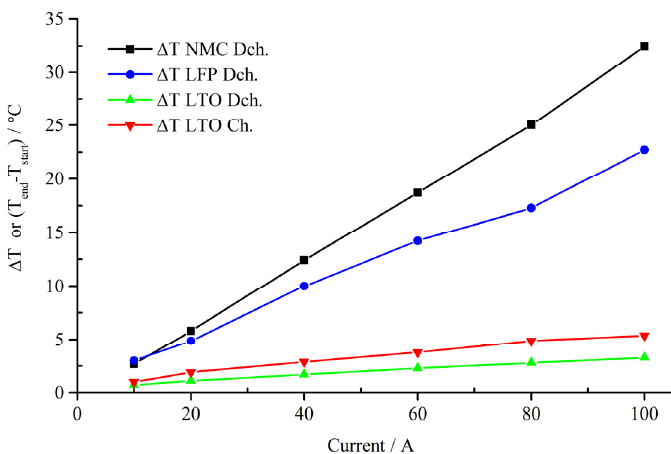
Figure 9. Temperature rise evolution in the NMC cell (during discharge), the LFP cell (during discharge) and the LTO cell (during both charge and discharge) at different current rates.